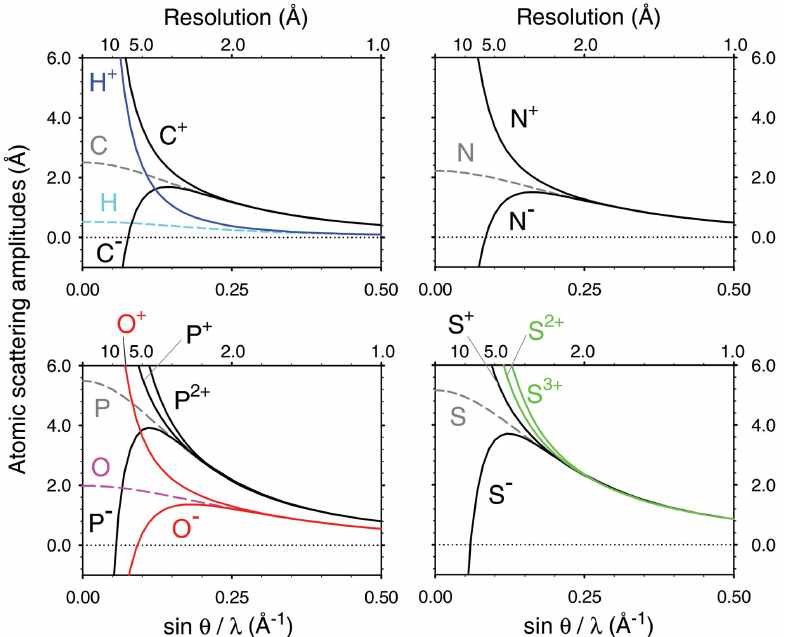
Figure 4 Plots of electron scattering factors converted from the X-ray scattering factors by the Mott formula (equation 4). Broken lines indicate plots for the neutral atoms. Negative ions show negative values in a lower sin (cid:2) / (cid:3) range. Magenta and red curves correspond to the scattering factors of O, O + and O (cid:2) , the cyan and blue curves are those of H, H + and the green curves are those of S 2+ and S 3+ . The scattering curve of H is derived from International Tables for Crystallography (Colliex et al. ,